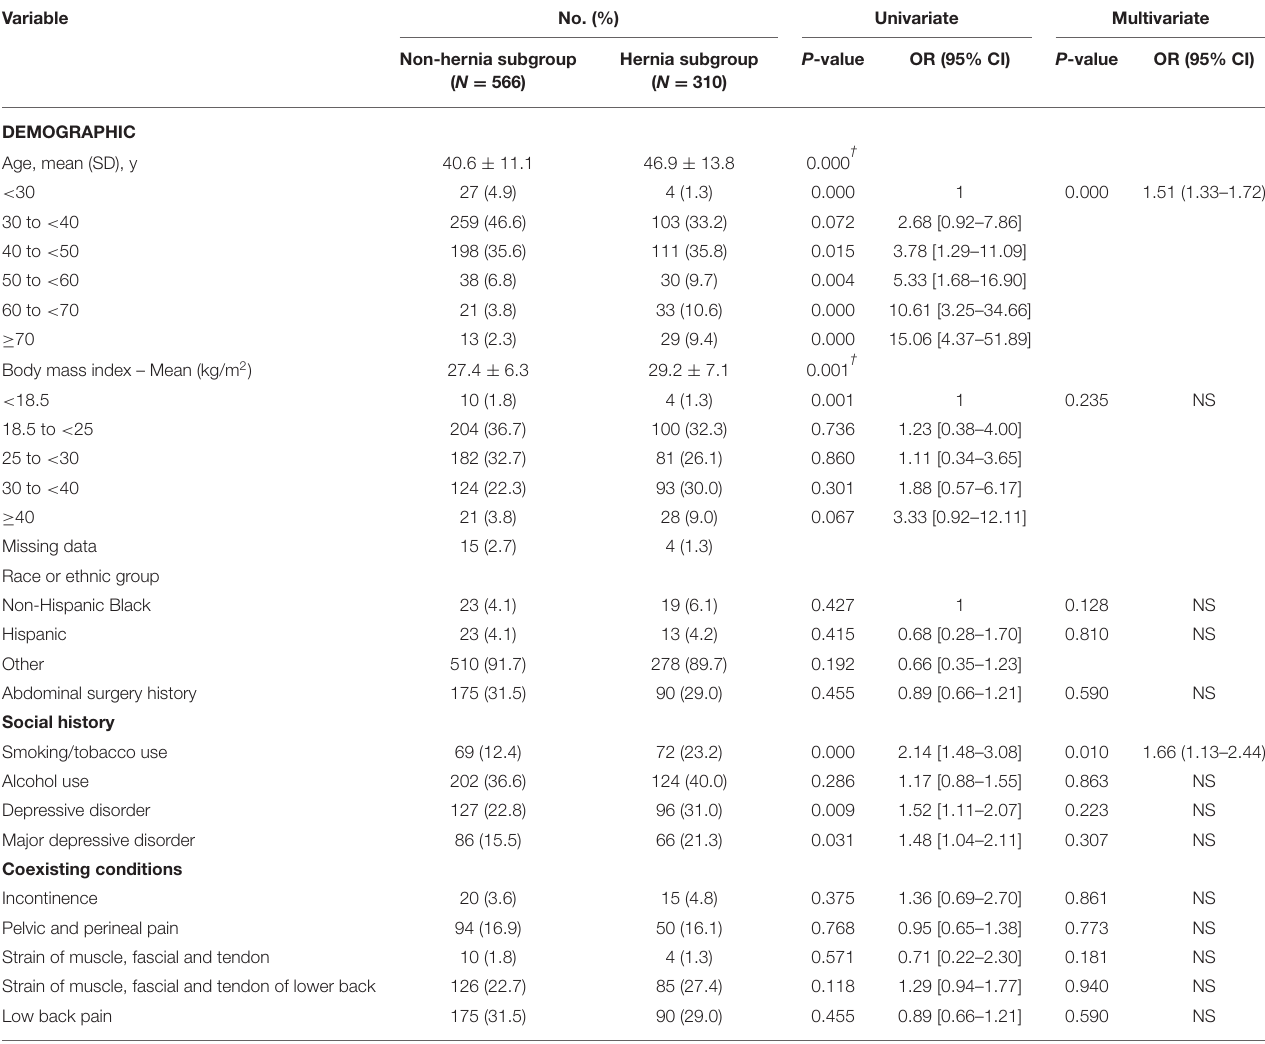
TABLE 5 | Characteristics of RAD women with or without hernia.